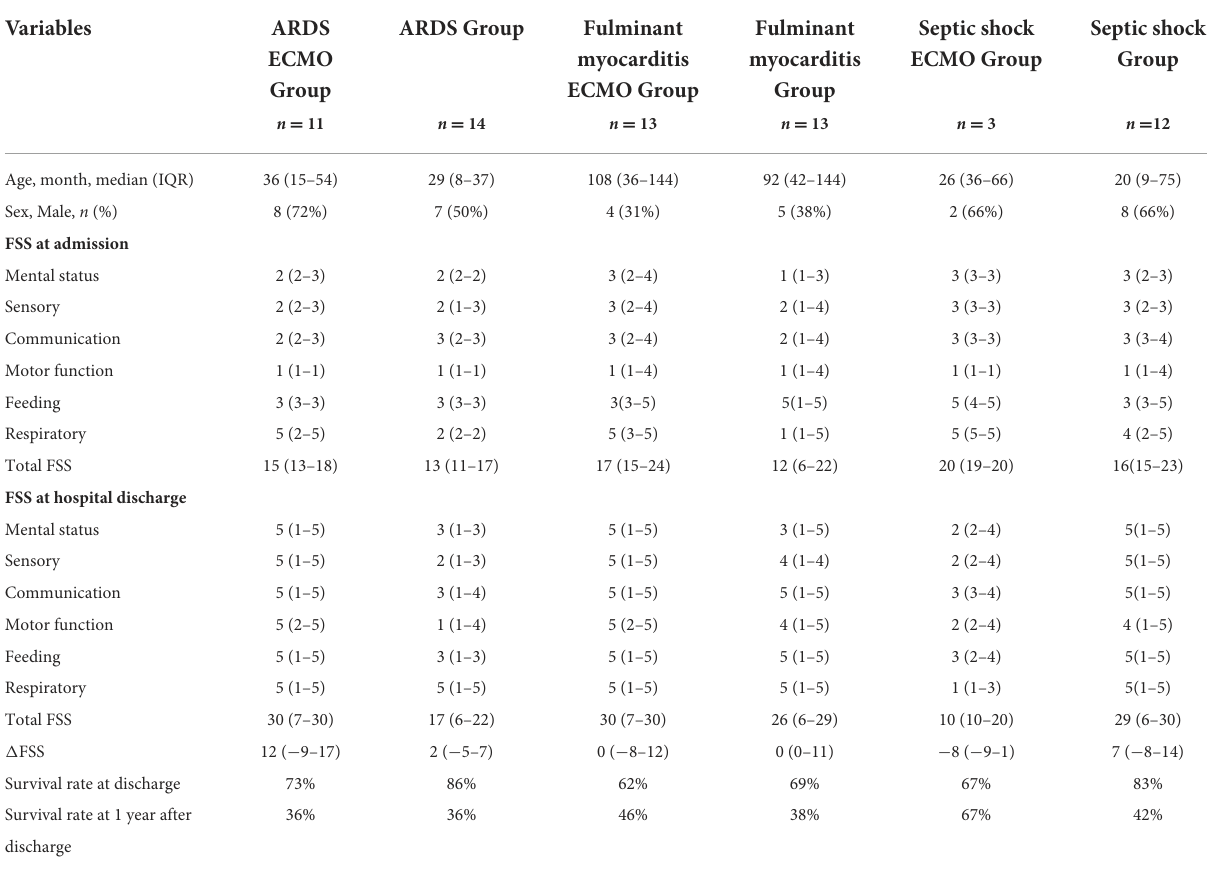
TABLE 5 Comparison of FSS scores in ECMO-treated patients and non-ECMO-treated